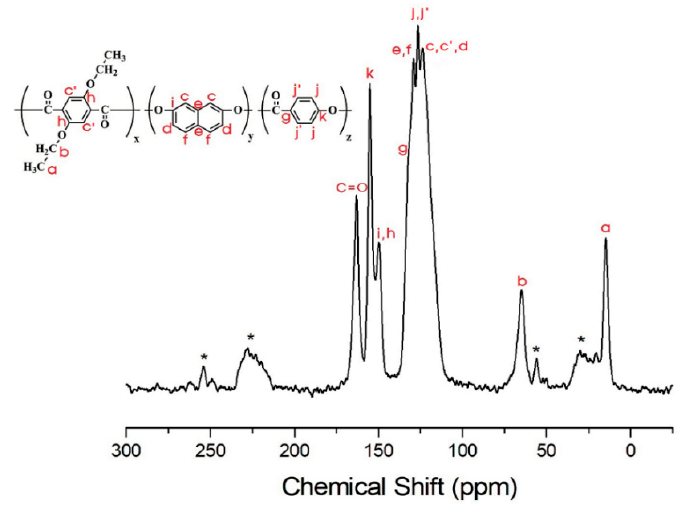
Figure 11. 13 C-NMR chemical shifts of sample II-A at room temperature. In the chemical formula, x:y = 1:1. The spinning sidebands are marked with asterisks.